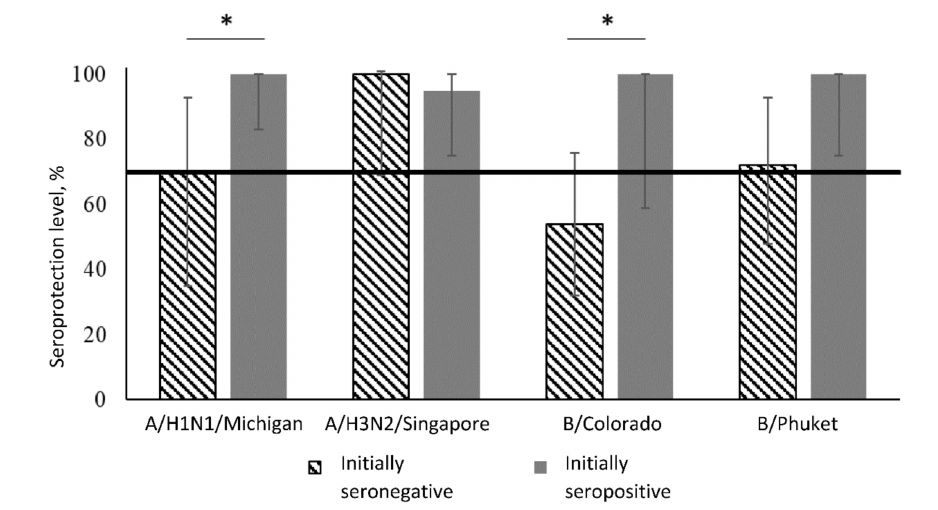
Figure 1. Seroprotection level 1 month after immunization given the initial level of antibodies in the group of healthy participants vaccinated with aQIV. Notes: *—statistically significant differences between groups. Seroconversion level (4-fold increase in HI titer ≥ 40% of participants) in vaccinated with aQIV